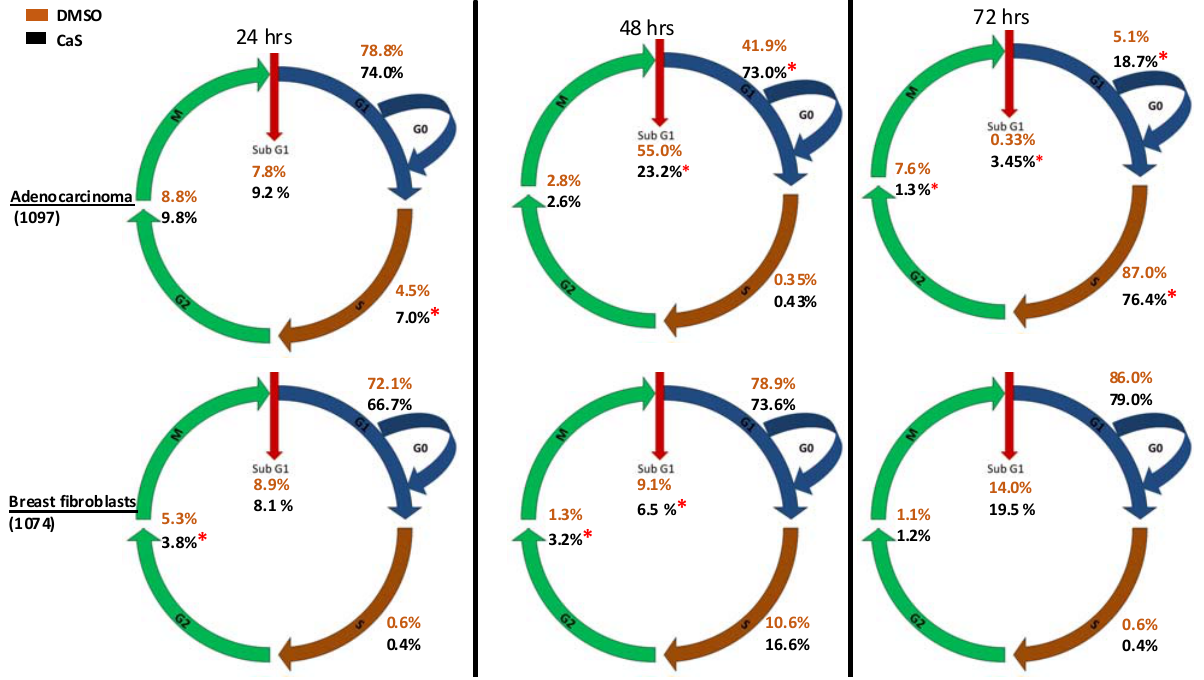
Figure 8. The upper and lower panel summarizes the effect of CaS nanoclusters in the progression of the cell cycle of breast adenocarcinoma and normal fibroblasts, respectively. The vehicle control is 2% DMSO. The total amount of Ca 2+ in the dispersion is 4 × 10 − 8 moles. The * indicates statistically significant values.